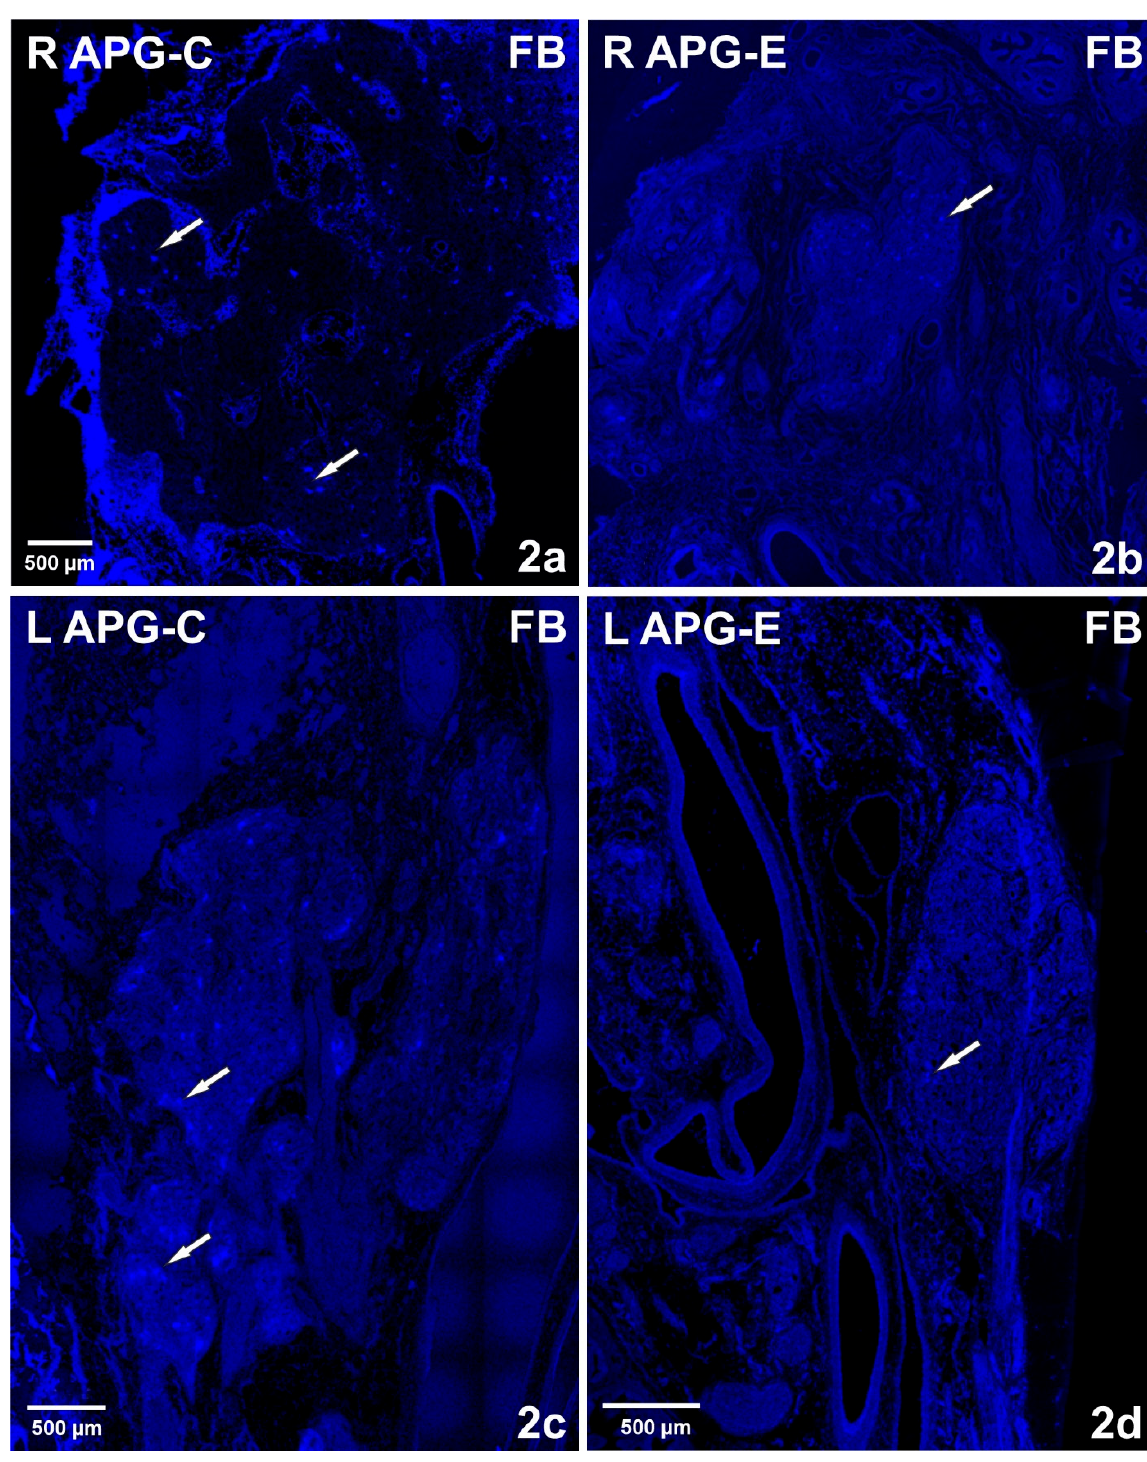
Figure 2. ( a , b ) Confocal laser scanning microscope images showing the distribution of FB+ neurons (in the right (R) APG from control (C) ( a ) and experimental (E) ( b ) animals. Significant reduction in the number of FB cells after unilateral axotomy surgery ( b ). Arrows indicate FB+ neurons. Scale bar = 500 µm. ( c , d ) Confocal laser scanning microscope images showing the distribution of FB + neurons in the left (L) APG from control ( c ) and experimental ( d ) animals. Marked loss of FB+ cells after right axotomy ( d ). Arrows indicate FB + neurons. Scale bar = 500 µm.